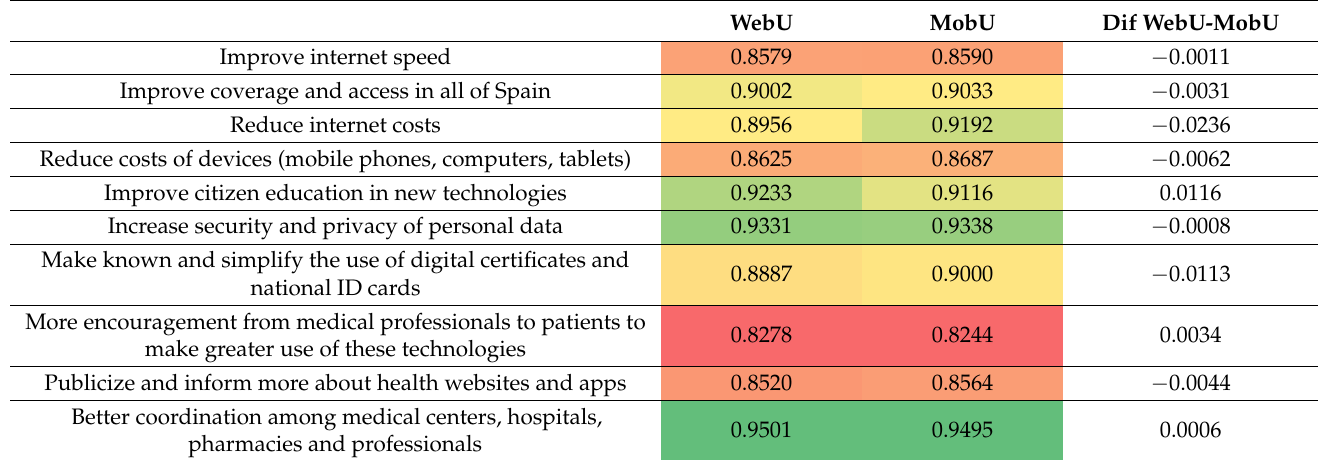
Table 4. Importance of measures to foster access to eHealth (by user